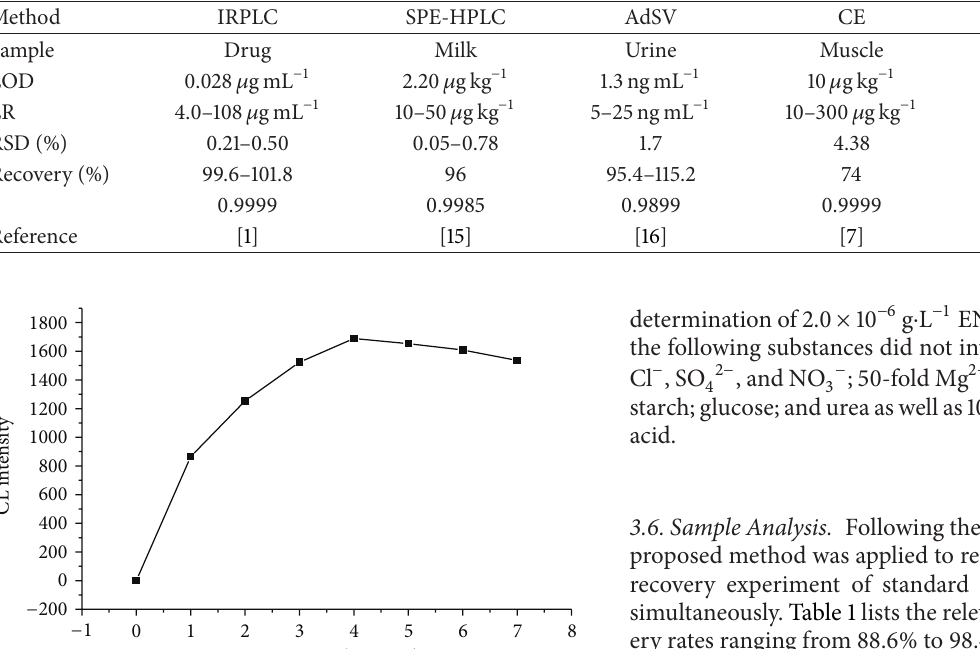
Table 2: Comparison of different methods for the determination of ENRO.